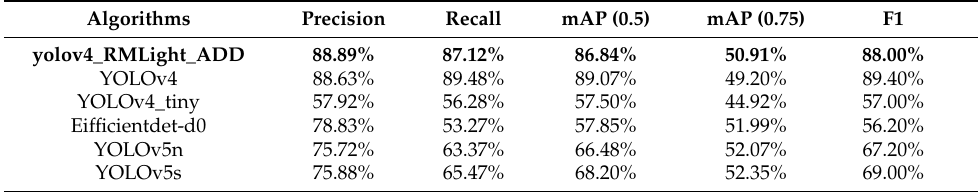
Table 6. Accuracy results for different detection models.